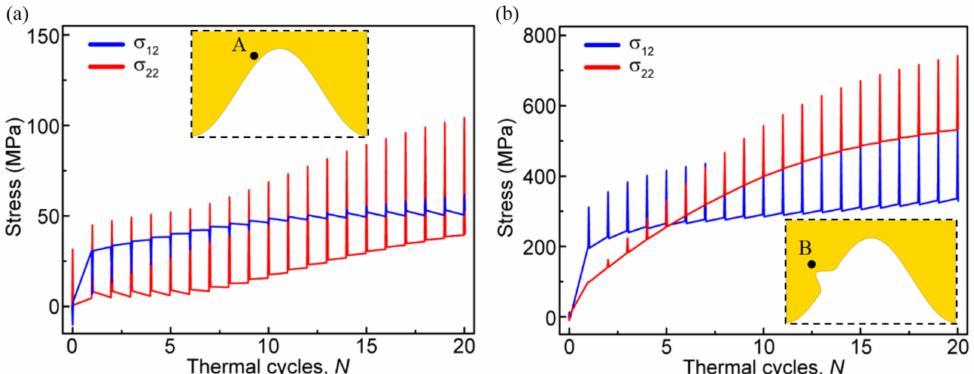
Figure 7. Variation of the normal and shear stress near the interface with the thermal cycles: ( a ) at point A near the interface without bulge and ( b ) at point B near the interface with one bulge.